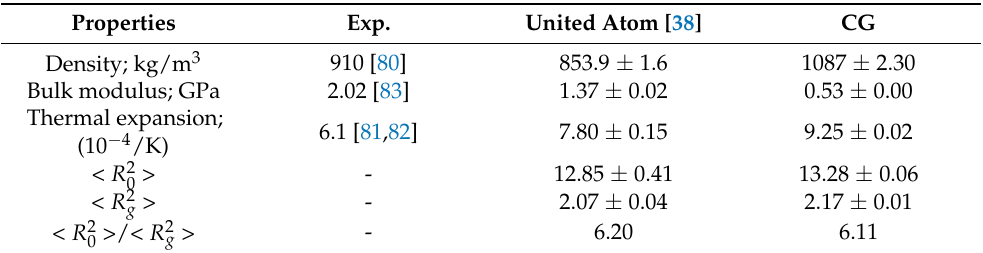
Table 1. Macroscopic and structural properties of cis -PI in melts. R 0 , R g , and < R 2 end-to-end distance, the radius of gyration, and polymer expansion factor, respectively. Properties